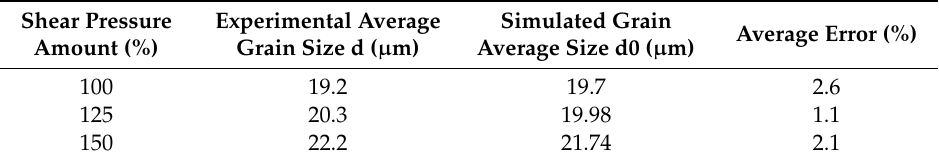
Table 8. Grain size during shear connection process.